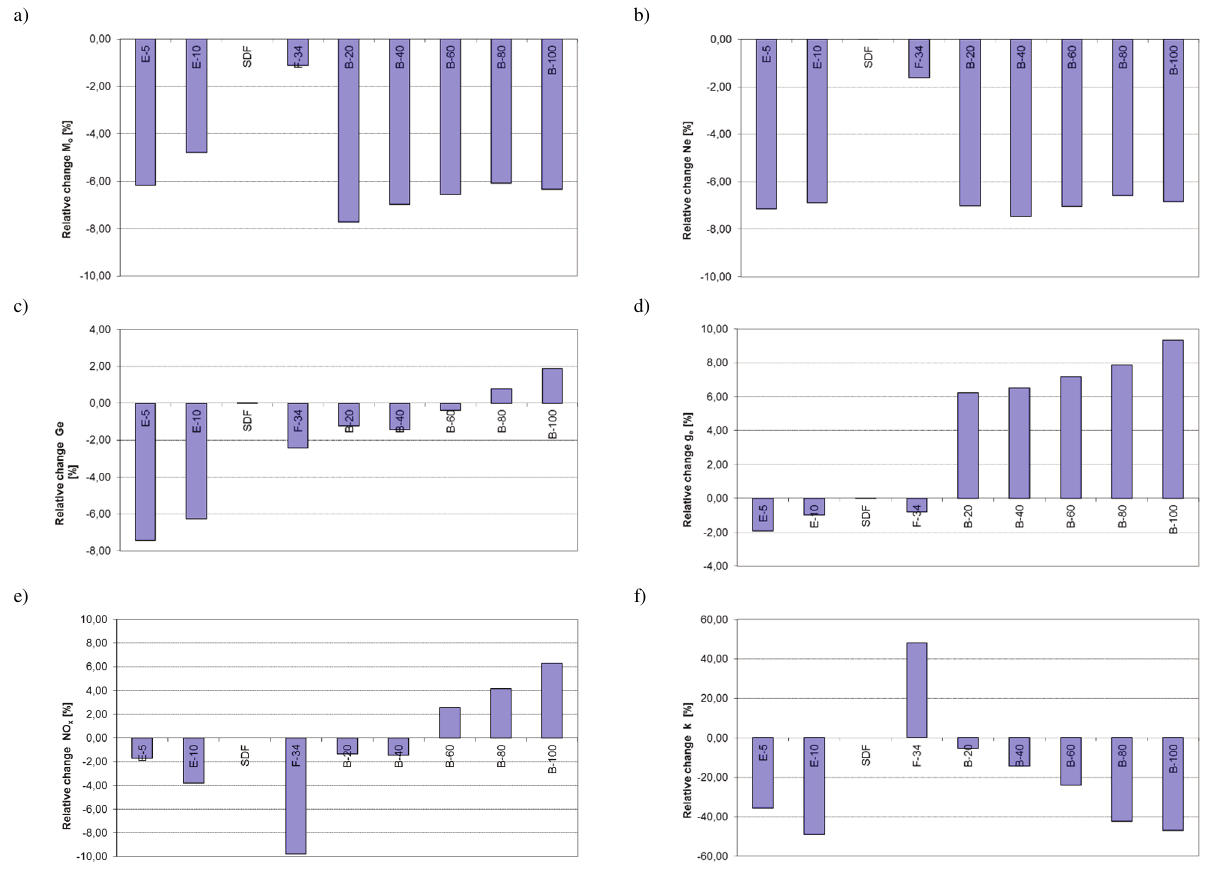
Fig. 2. Relative changes in engine operating parameters for maximum torque – 1500 rpm: a) torque, b) effective power, c) fuel consumption, d) specific fuel, e) concentration of nitrogen oxides in exhaust, f) extinction coefficient of absorbed radiation